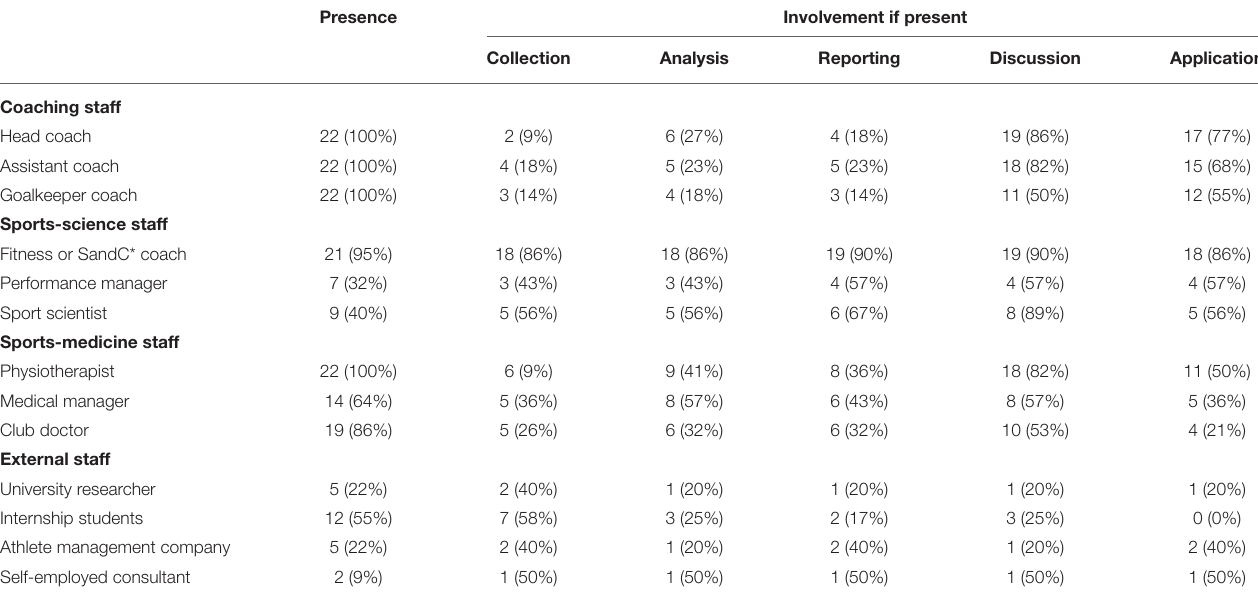
TABLE 3 | Presence and involvement of the different types of staff members in the monitoring process. Values are presented as the number (proportion) of clubs. Presence Involvement if present Collection